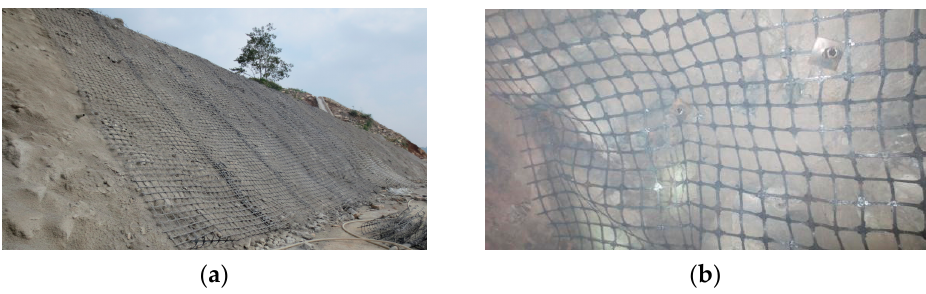
Figure 1. Engineering application of a steel–plastic compound geogrid: ( a ) s lope support ( b ) road- way support.